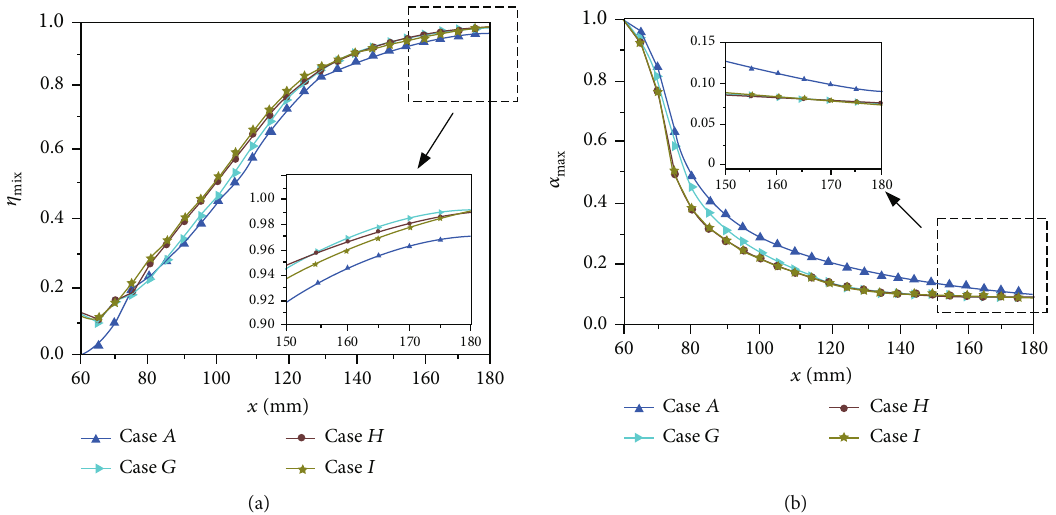
Figure 13: Mixing e ffi ciency of ethylene (a) and the corresponding maximum concentration decay curve (b) in case A without actuation and case G -case I with spanwise actuation downstream of the ori fi